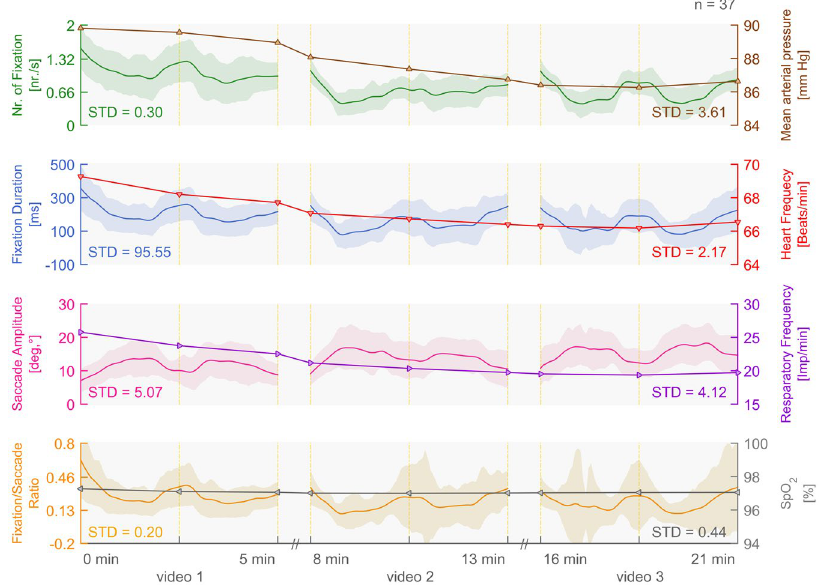
Figure 1. Vital parameters pooled with oculomotor data of healthy participants (n = 37, age M = 48 years, SD = 17). The oculomotor data (fixation duration, number of fixations, saccade amplitudes and fixation/saccade ratio) is based on moving window calculations, whereas the vital sign measurements (MAP, HF, RF and SpO 2 ) were sampled at each data points